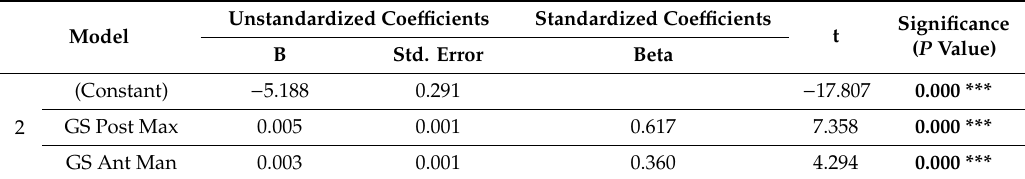
Table 7. Linear regression analysis with Stepwise method for prediction of T value using GS values at di ff erent jaw regions as independent variables at 95%